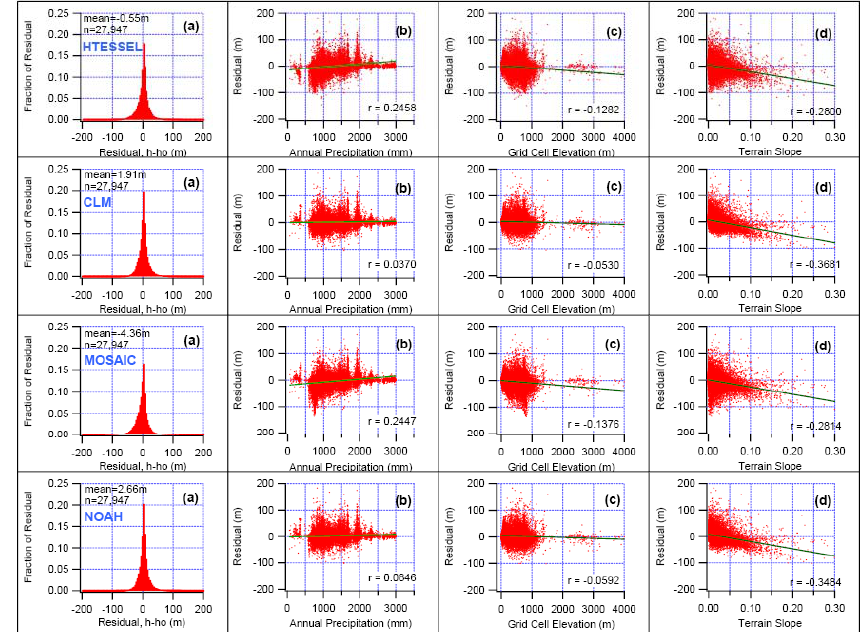
Fig. 6. Residual statistics for the four simulations: (a) histogram of the residual (modeled head - observed head), (b) residual vs. annual precipitation, (c) vs. land elevation, and (d) vs. terrain slope, with the Pearson correlation coefficient ( r )